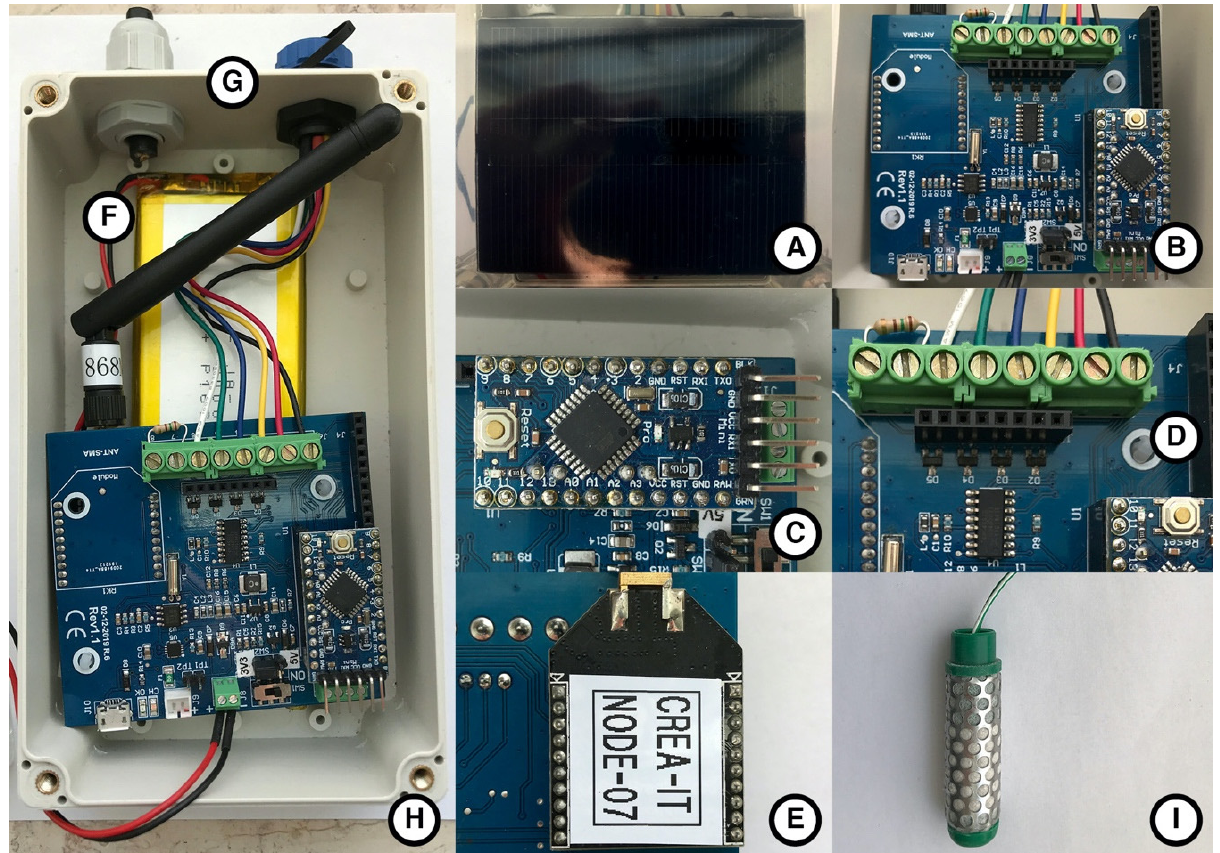
Figure 2. Soil moisture LoRa (long-range) device ( H ) and the solar panel needed to charge the LiPo battery ( A ). The main interface expansion shield used by the microcontroller ( B ), which is an Arduino Mini Pro ( C ) providing all the inputs and outputs pins ( D ). Below this, the electronics lies the LiPo battery ( F ) (1S, 3000 mAh). This board is equipped with a socket (XBee form factor) for the wireless hardware, LoRaWAN (long-range wide-area network), used to connect to the main gateway (LoRaWAN protocol) ( E ). In addition, a waterproof connector provides connectivity with the soil sensors ( G ). Soil moisture sensor resistant electrodes ( I ).